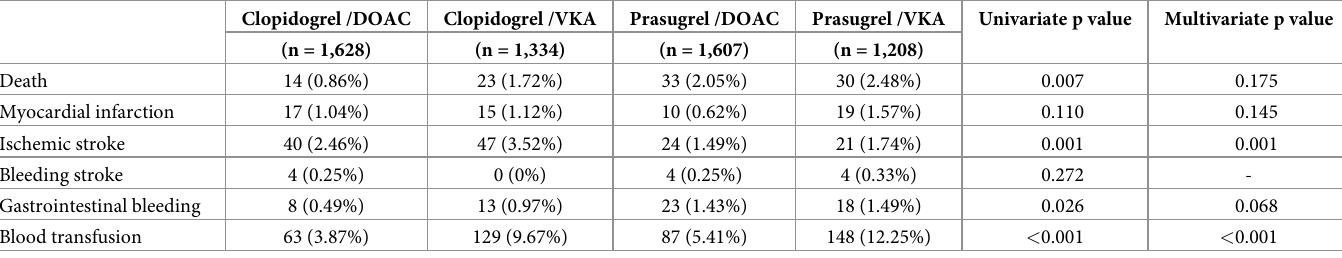
youngest patient age compared with other 3 groups. There were more males, CKD, and pre- scription of NSA in the VKA groups, regardless of the type of P2Y12 inhibitor. While the pra- sugrel groups had more dyslipidemia, AMI presentation, and prescription of statins, ACE-I/ ARB, and PPI, the clopidogrel groups showed a higher prevalence of diabetes, regardless of the type of OAC. Hospital stay was the longest in the prasugrel/VKA group compared with the other 3 groups. The incidence of in-hospital clinical events and the results of univariate and multivariate analyses were shown in Tables 2–4. The multivariate analyses demonstrated that the incidence of ischemic stroke and blood transfusion were significantly different among the 4 subgroups in all patients (p = 0.001 and p < 0.001, respectively), that the incidence of death and blood Table 2. Total clinical events: All